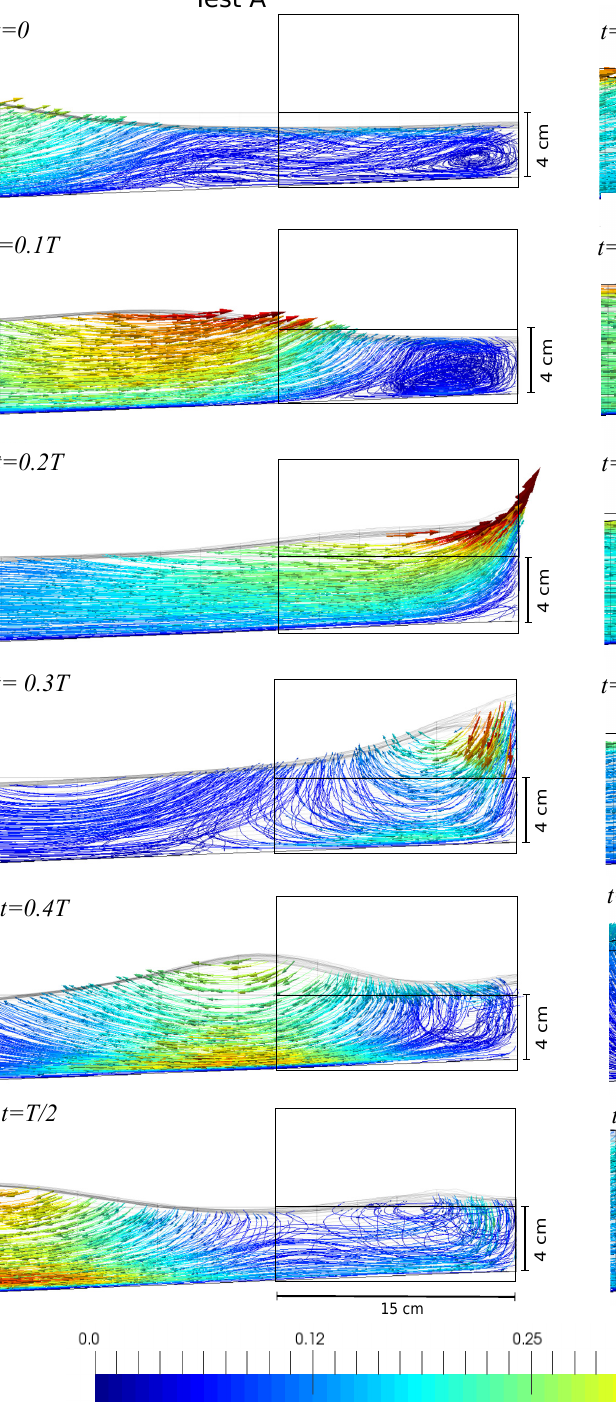
Figure 11. Numerical results of the instantaneous velocity field for Test A and B. The box corresponds to the PIV measure- ment zone. The 4 cm and 6 cm legends mean the still water levels at the